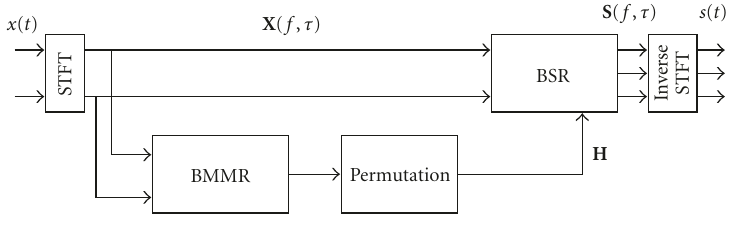
Figure 1: Overall unmixing